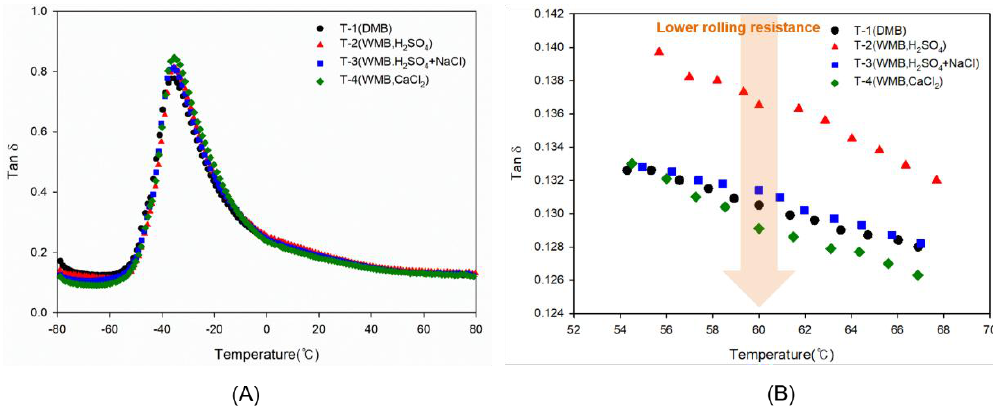
Figure 7. Tan δ graphs of the T-1 to T-4 compounds as a function of temperature: ( A ) from − 80 to 80 ◦ C and ( B ) from 54 to 68 ◦ C. These graphs show that rolling resistance and wet traction performance: the black color symbol shows the hysteresis behavior of the T-1 DMB compound, the red symbol shows the hysteresis behavior of the T-2 WMB compound, the blue symbol shows the hysteresis behavior of the T-3 WMB compound, and the green symbol shows the hysteresis behavior of the T-4 WMB compound. Table 12. Viscoelastic properties of the T-1 to T-4 compounds.